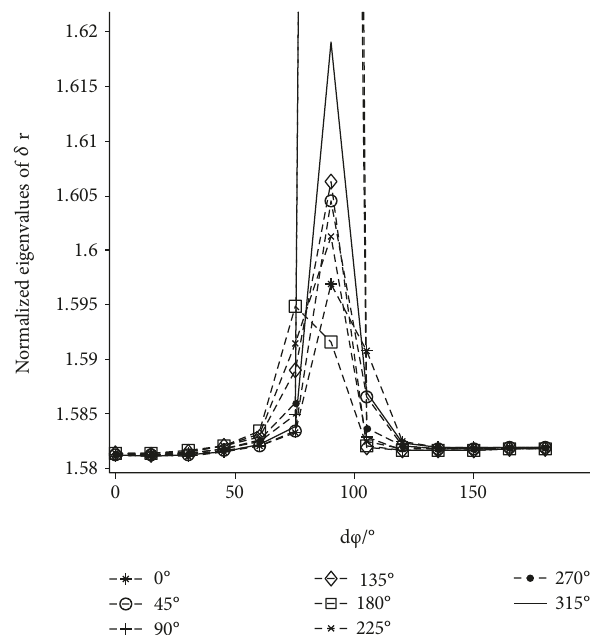
Figure 8: Normalized eigenvalues of the linear distance error between the AUV and the beacon under di ff erent current